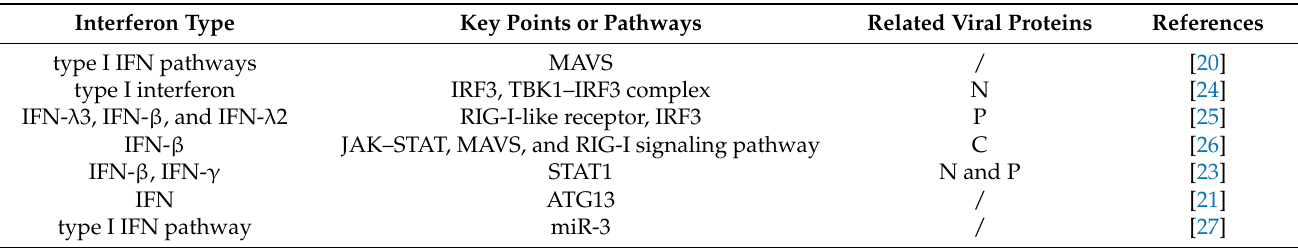
Table 1. Summary of PPRV and IFN pathway